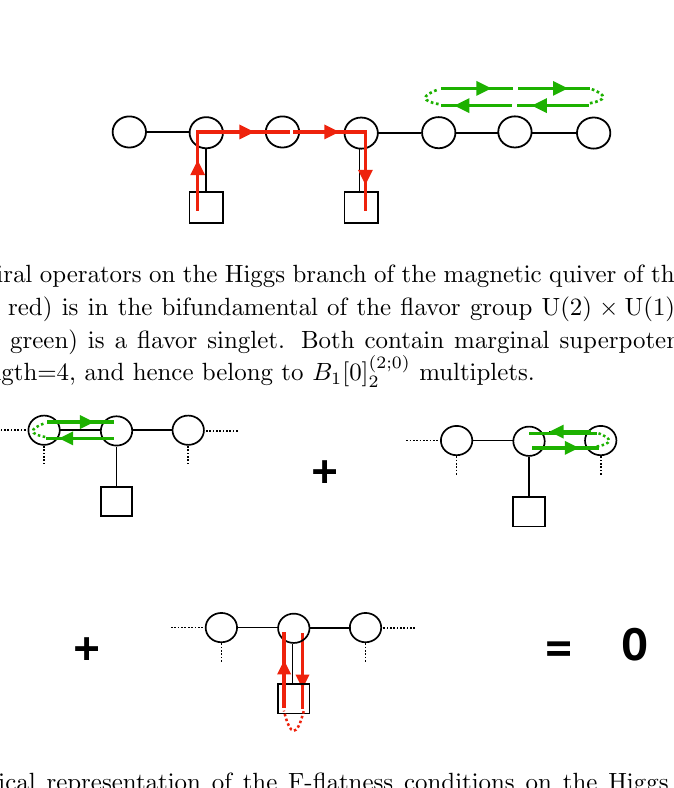
Figure 4 . Graphical representation of the F-(cid:13)atness conditions on the Higgs branch, as linear relations among cut-open string segments. The dotted red semicircle in the third term stands for a summation over the free (cid:13)avor indices of the open